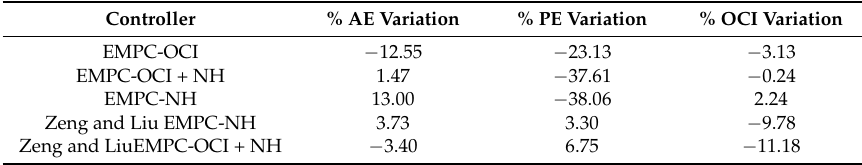
Table 4. Performance indices variation respect to the BSM1 PI default